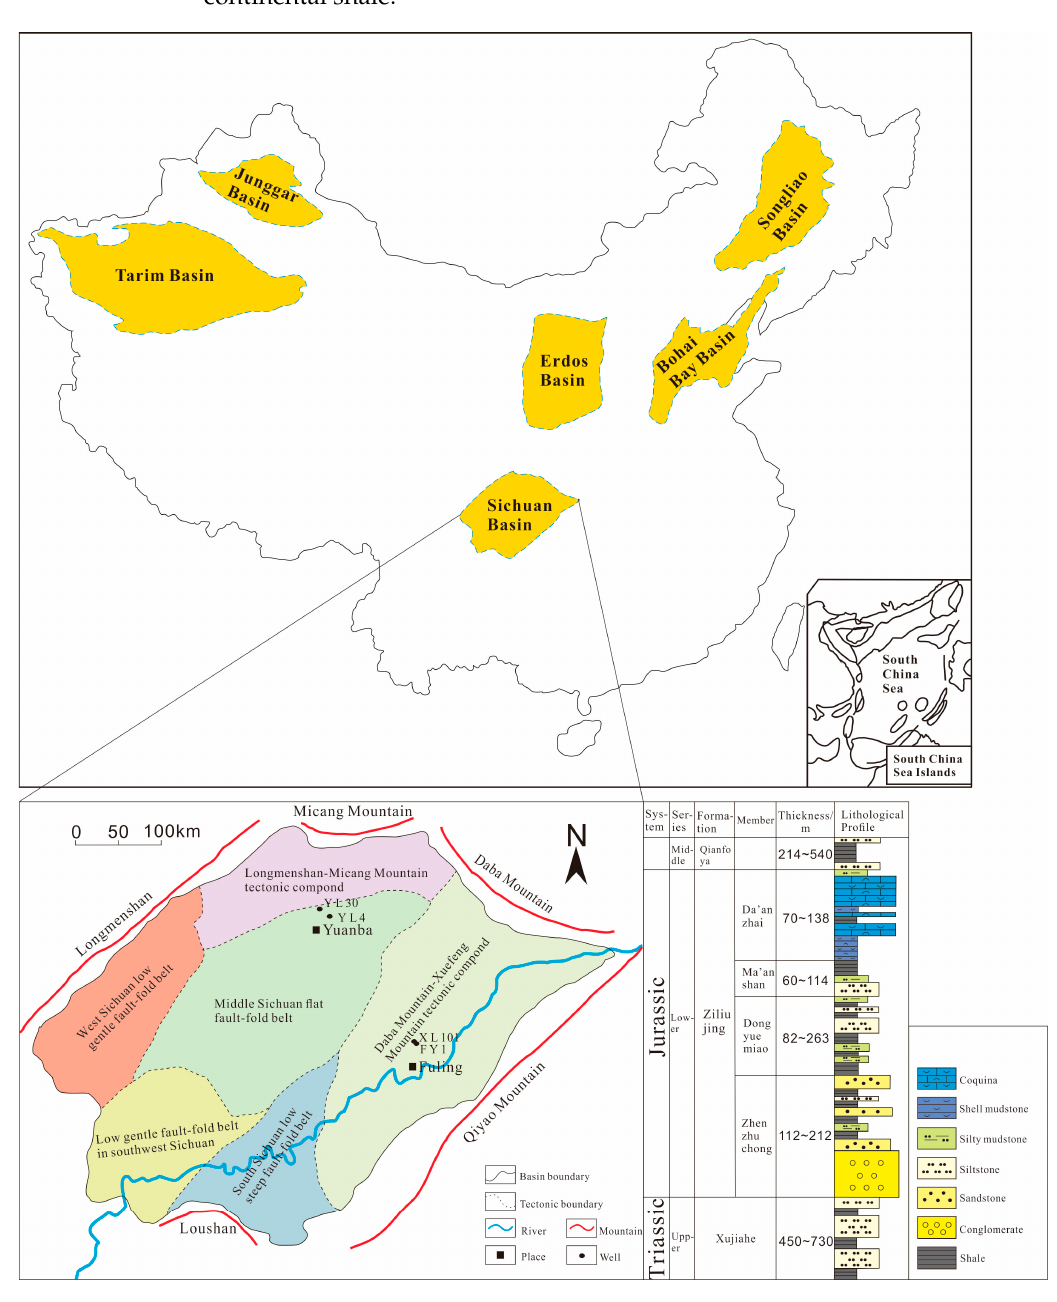
Figure 1. Regional structural map of the Sichuan Basin and a columnar section of the Jurassic Ziliujing Formation.